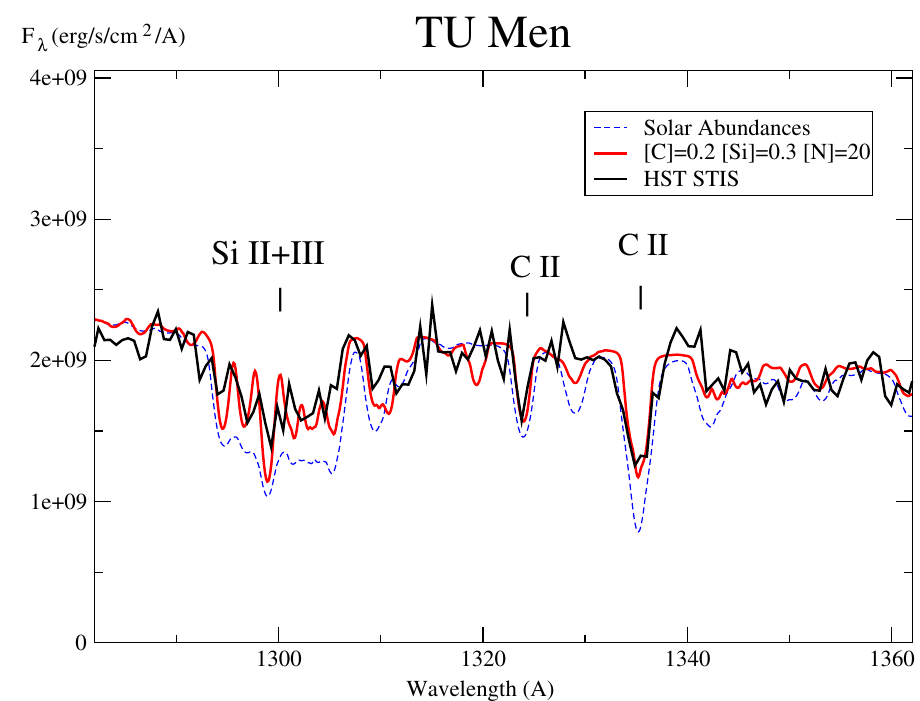
Figure 6. Detail showing the fit to carbon and silicon absorption lines. The HST spectrum is in black, the model is shown in red, and for comparison, a solar abundance model is shown with the blue dashed